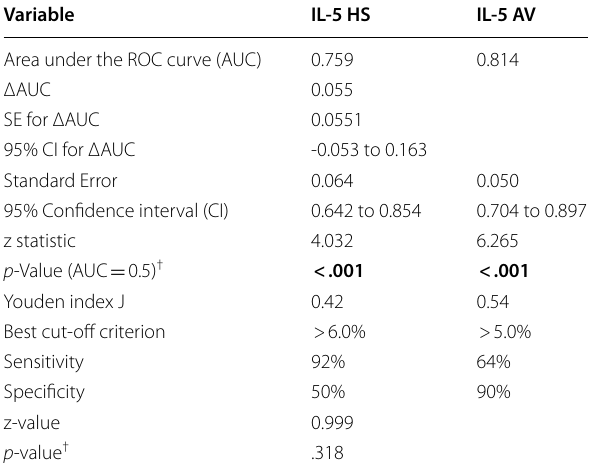
Table 3 Response-operating characteristic (ROC) curve analysis for discrimination between cases and controls using IL-5 and comparison of the (ROC) curves for discrimination between cases and controls using IL-5 HS or IL-5 AV